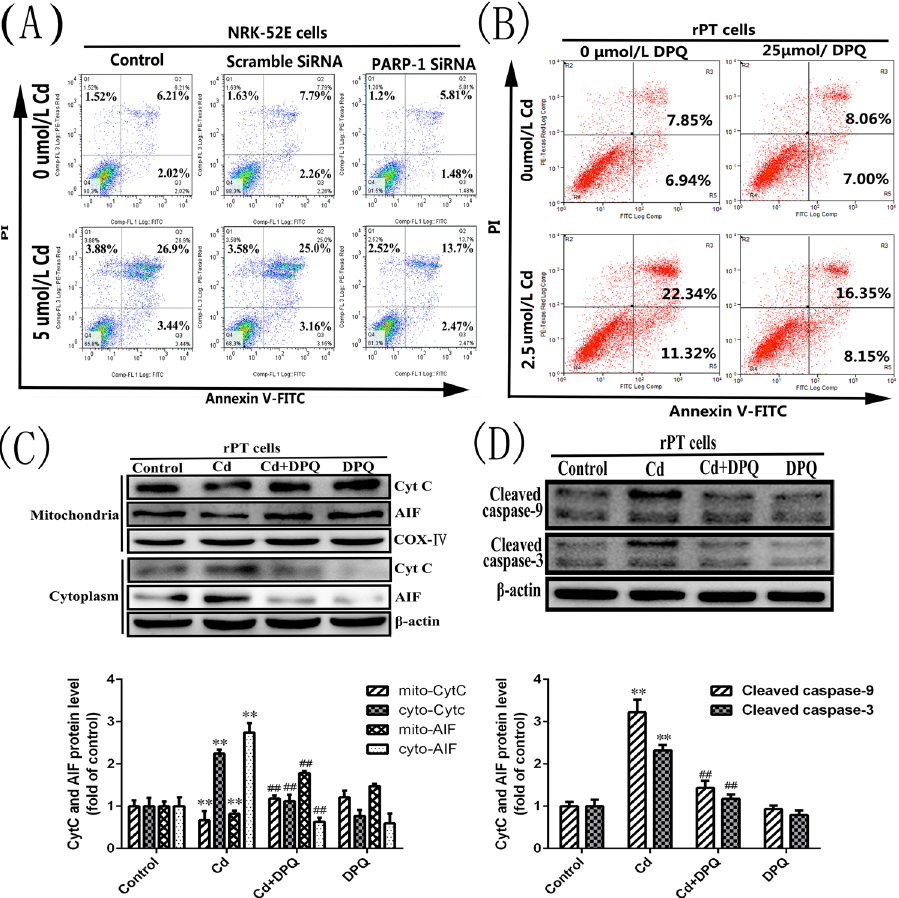
Figure 8. Effects of PARP-1 on Cd-induced apoptosis and expression of related proteins in the mitochondrial apoptosis pathway. ( A and B ) After treatment with Cd, the apoptosis rate of NRK-52E cells and primary rPT cells increased, compared with the control group. When the PARP-1 gene was silenced or PARP-1 protein activation was inhibited, the apoptosis rate of Cd-treated NRK-52E cells or primary rPT cells decreased compared with the Cd group. ( C and D ) Western blot analysis of the release of Cyt C and AIF and the expression of Cleaved caspase-9/3 in primary rPT cells after treated with Cd and/or DPQ for 12 h. Data are expressed as mean ± SD (n = 3) relative to control. ** P < 0.01 in comparison to the control by one-way ANOVA. ## P < 0.01 in comparison to the Cd group by one-way